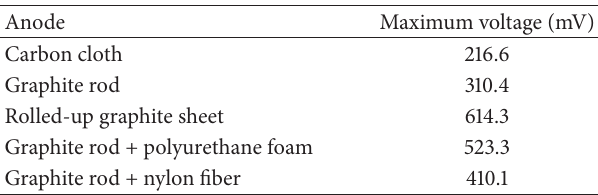
Table 1: Maximum voltage values